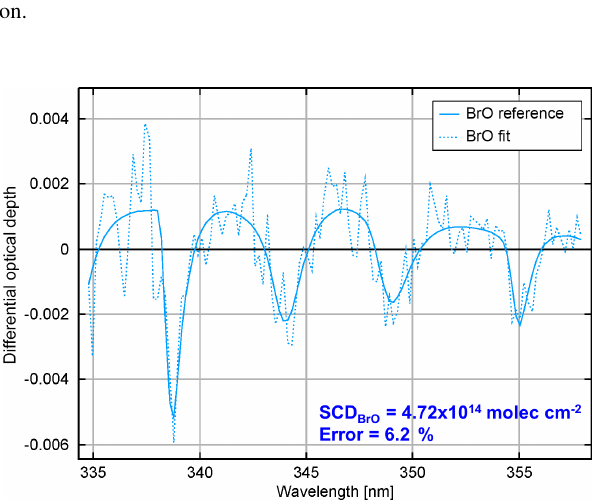
Figure 9. Example of a BrO fit result applying DOAS settings of Table 2 in the Arctic BrO measurement case. The dashed line shows fit results including the fitting residual and the solid line is the ref- erence spectrum scaled according to the fit